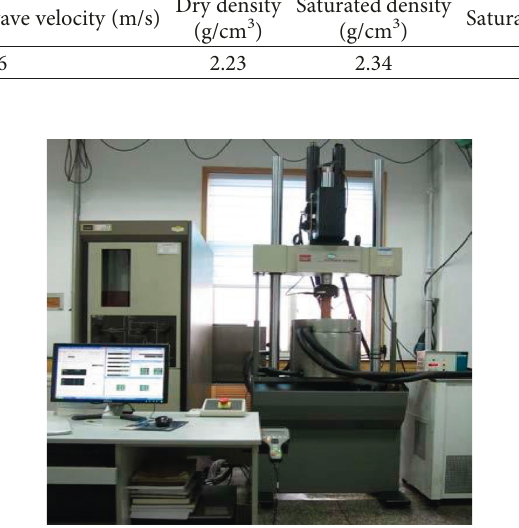
Figure 2: Testing system for rocks at low temperatures.